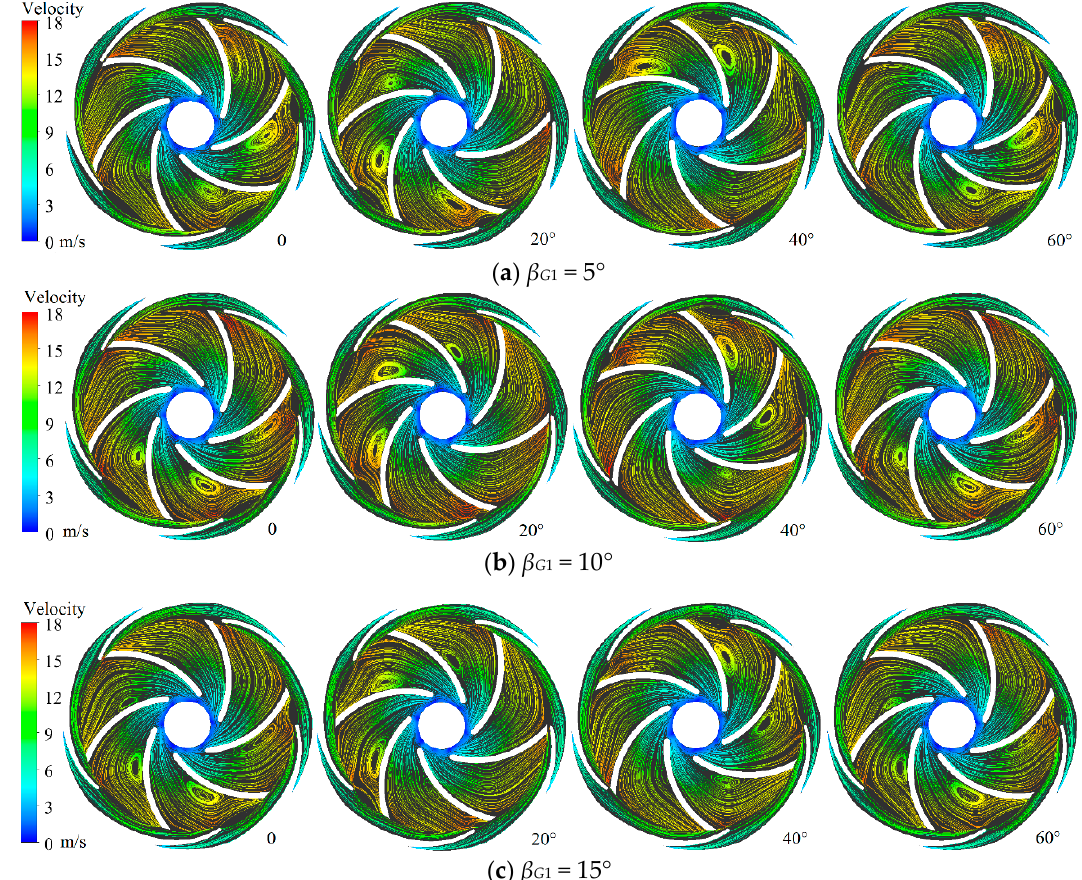
Figure 21. Evolution processes of the transient flow field inside the impeller and guide vane with different inlet angles of the positive guide vane.